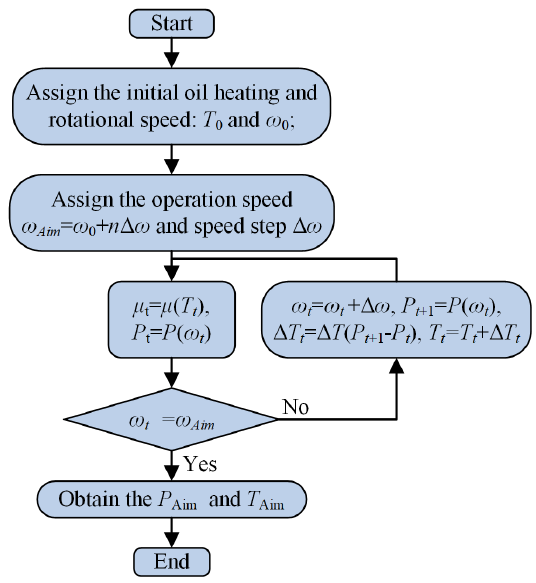
Figure 6. Fluid friction calculation flowchart based on variable viscosity theory.